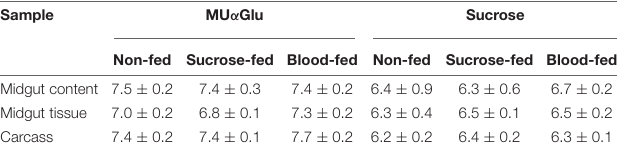
TABLE 1 | pH optimum of α -glucosidases obtained from different samples of L. longipalpis females under different physiological conditions, using MU α Glu or sucrose as